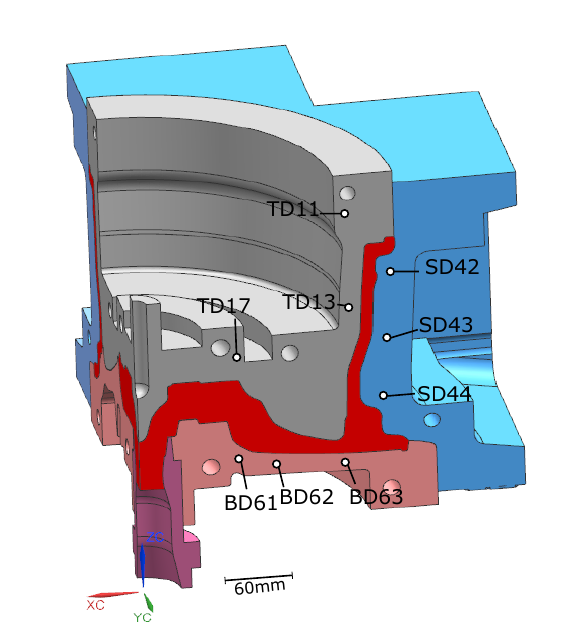
Figure 7. Thermocouple (TC)